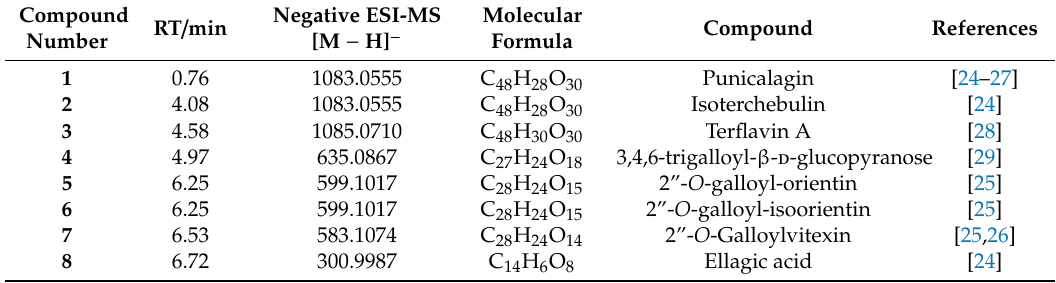
Table 6. Identification of phenolic compound in T. bentzoë butanol fraction F6 using high-resolution mass spectrometry, NMR spectroscopy, and comparison with the literature and available